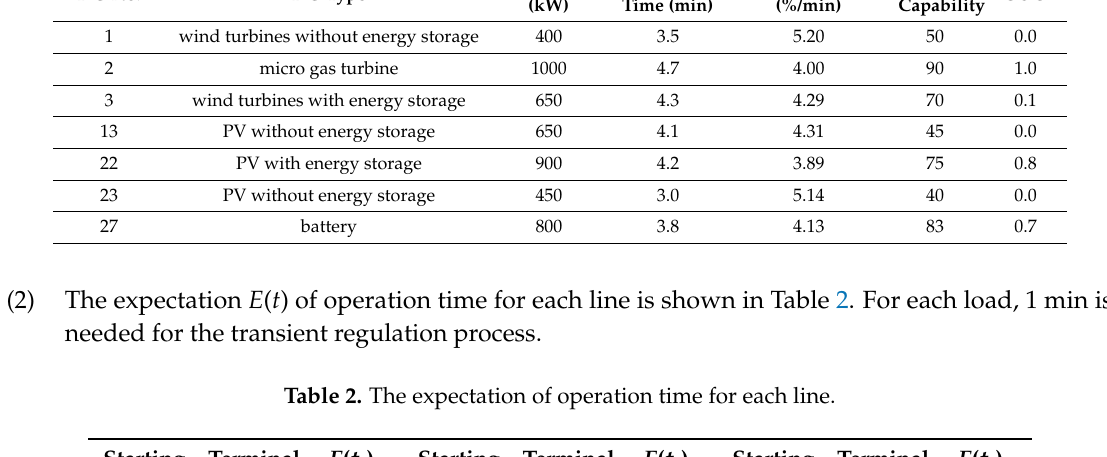
Figure 2. Structure of 30-bus microgrids. Table 1. The parameters of distributed generations (DGs). VVVF: variable voltage and variable frequency; SOC: State of Charge; PV: photovoltaics. DG No.